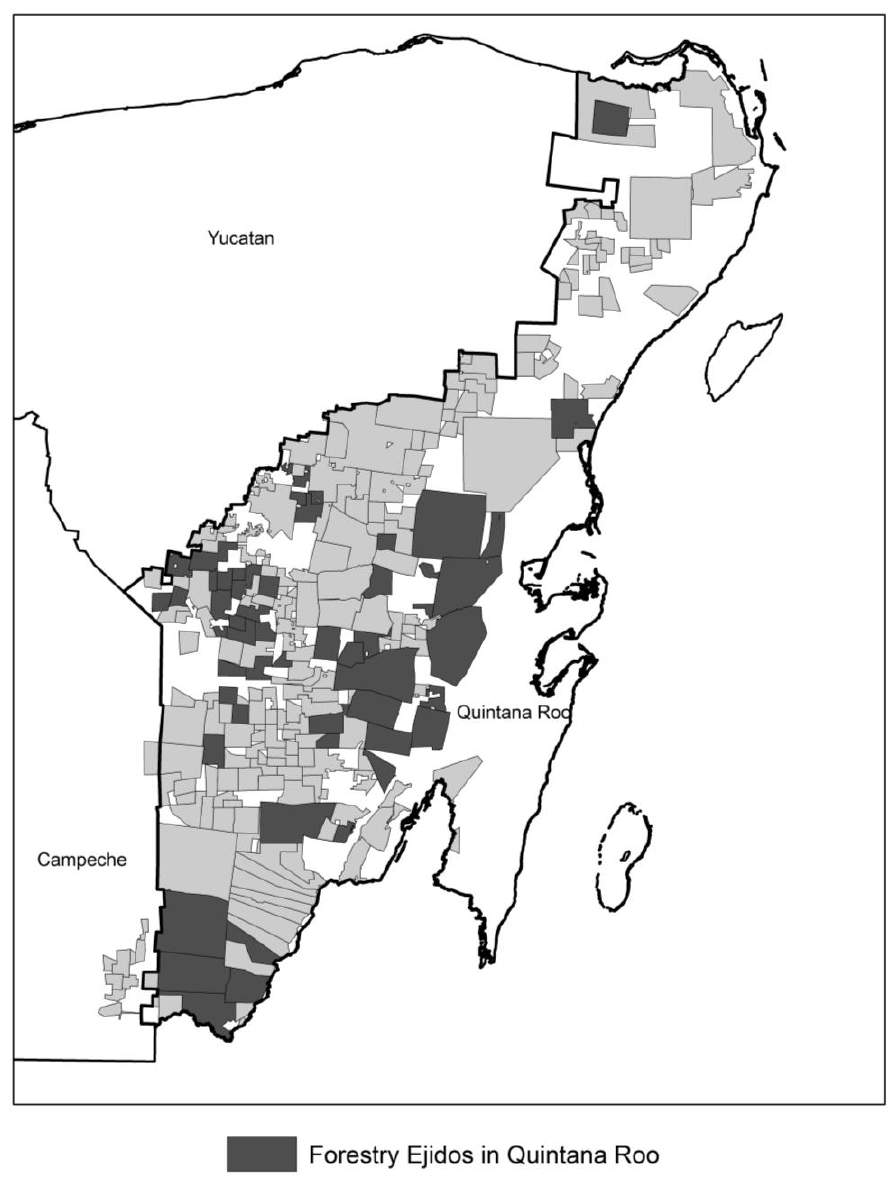
Figure 1. Location of forestry ejidos in Quintana Roo with active forest management plans in